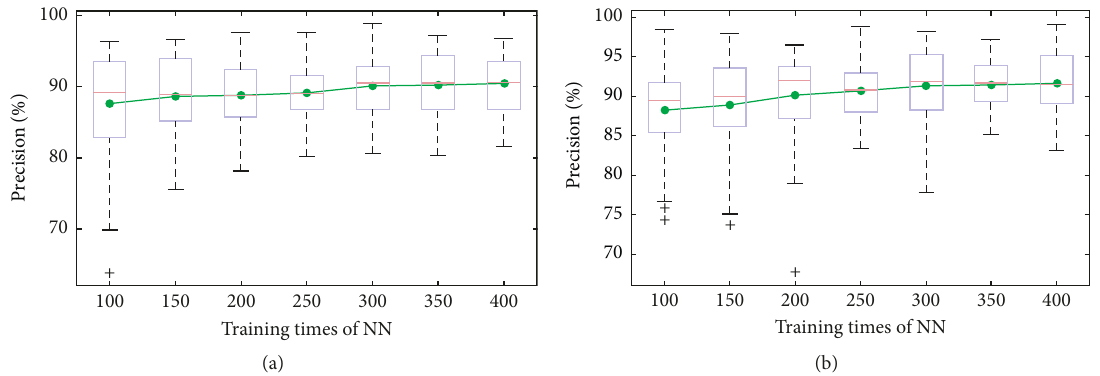
Figure 13: Prediction precision versus training times of NN. (a) Ratio of training set � 60%; (b) ratio of training set �